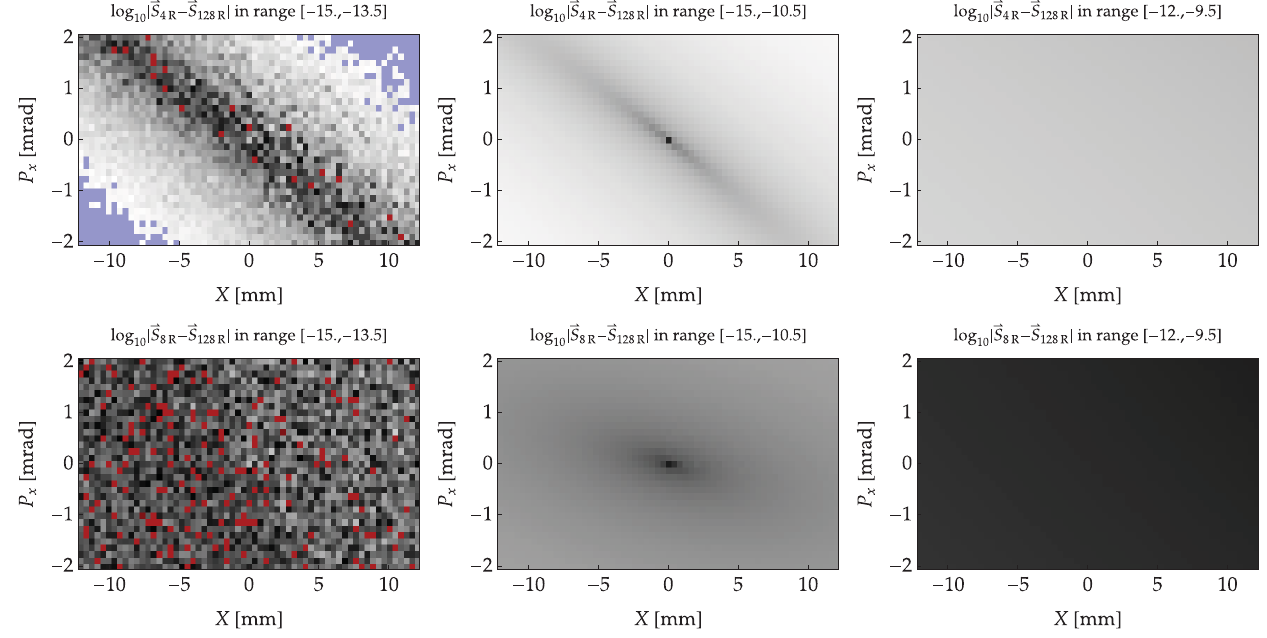
FIG. 9. Absolute error in the computed spin across a RHIC dipole for a range of initial conditions in orbital phase space. Each of the graphics in this figure shows results for the same orbital initial conditions and the same number of slices as the corresponding graphic in Fig. 8. The differences are that the integration here includes one Romberg step, and the error ranges are significantly